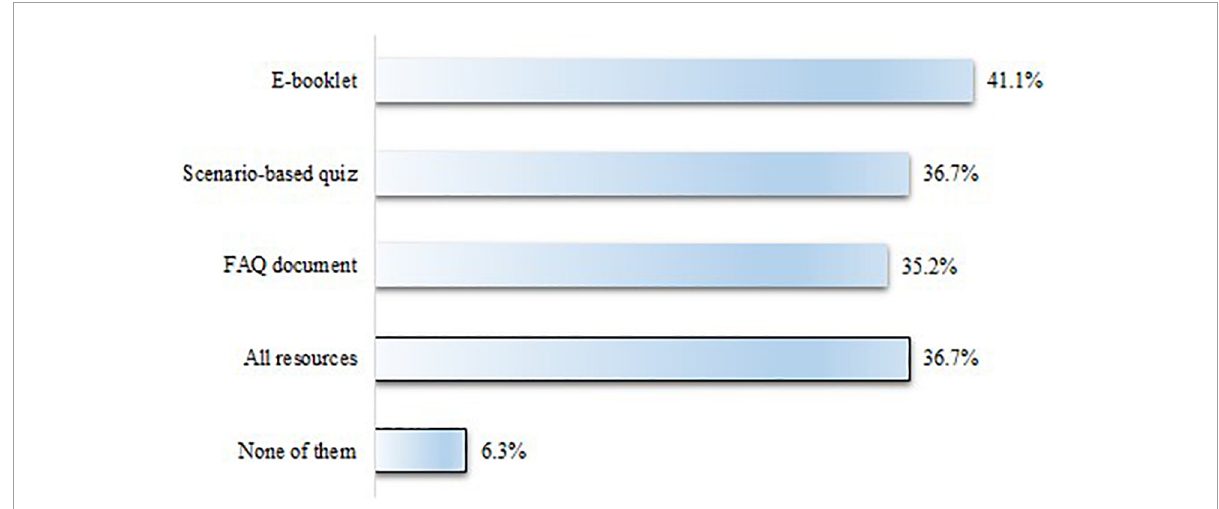
FIGURE4 New academic integrity resources as ranked by perceived usefulness (according to student